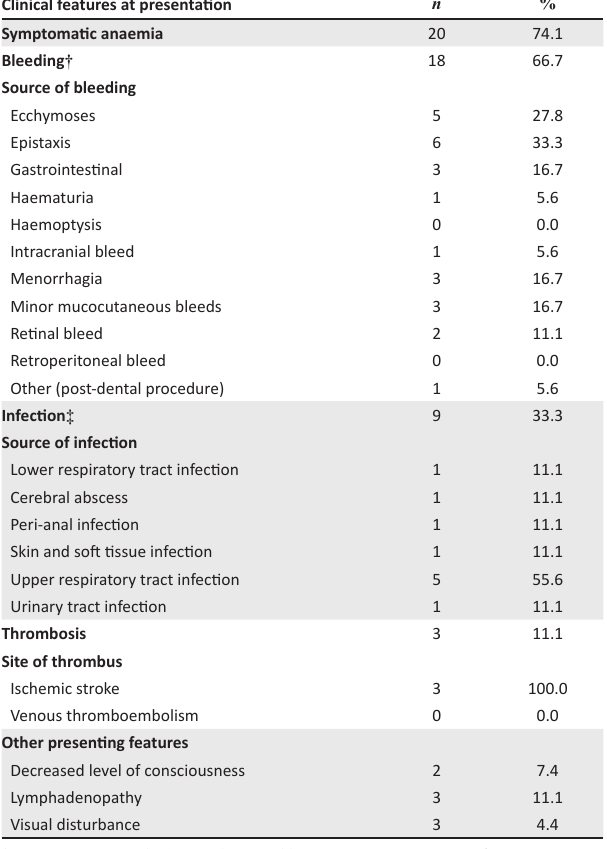
TABLE 1: Clinical features of patients with acute promyelocytic leukaemia at first presentation to Universitas Academic Hospital. Clinical features at